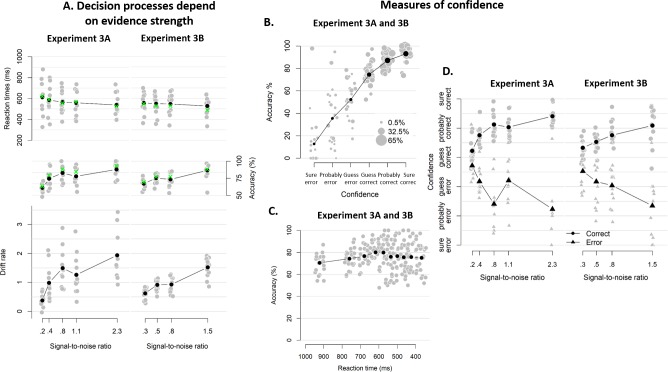
Behavioral results of Experiment 3.(A) Mean reaction time on correct trials (top), accuracy (upper middle) estimated mean drift rate (lower middle), and confidence (bottom) as a function of coherence level. RTs on correct trials and choice accuracy scaled with SNR In both experiments (Exp 3A: RT, F(4, 3012.3)=21.60, p<0.001, error rates, X²(4)=170.74, p<0.001; Exp 3B: RT, F(3, 2173.1)=3.07, p=0.027, error rates, X²(3)=83.311, p<0.001). Correspondingly, drift rates estimated from fits of a hierarchical drift diffusion model also increased monotonically with SNR in both experiments (Exp 3A: Friedman χ2(4)=41.02, p<0.001; Exp 2B: Friedman χ2(3)=31.61, p<0.001). In these model fits, decision bound was not allowed to vary as a function of SNR, and its average was 1.33 (SD = 0.17) and 1.33 (SD = 0.20) in Experiment 3A and 3b, respectively. Similarly, non-decision time was estimated independently from SNR, and its average was 0.28 (SD = 0.08) and. 022 (SD = 0.05). Green crosses show the fits from the DDM. (B) Accuracy as a function of decision confidence. Confidence ratings were closely linked to choice accuracy, even on a trial-by-trial basis while including SNR as a covariate (logistic regression of confidence on accuracy: significant positive slopes for 21 observers, with all ps < 0.001, and non-significant positive slopes for two observers, with both ps > 0.354), showing that confidence predicts accuracy over and above SNR. Dot size reflects the percentage of trials per confidence label, separately for each participant. (C) Accuracy as a function of reaction time. There was no linear relationship between RTs and accuracy, b = −0.001, p>0.545. A polynomial regression did, however, confirm the inverted U-shape seen in the data, t(29.2) = −3.19, p=0.003. (D) Confidence as a function of coherence level, separately for corrects and errors. Confidence judgments only scaled with SNR in Experiment 3A (Exp 3A: F(4,3953.9) = 37.34, p<0.001; Exp 3B: F(3,2867.1) < 1, p=0.141), but there was a highly significant interaction between SNR and accuracy in both versions of the experiment (Exp 3A: F(4,3955.1) = 87.59, p<0.001; Exp 3B: F(3,2867.8) = 48.16, p<0.001): confidence increased with SNR for corrects (linear contrast: Exp 3A: p<0.001; Exp 3B: p<0.001) and decreased with SNR for errors (linear contrast: Exp 3A: p<0.001; Exp 3B: p<0.001).